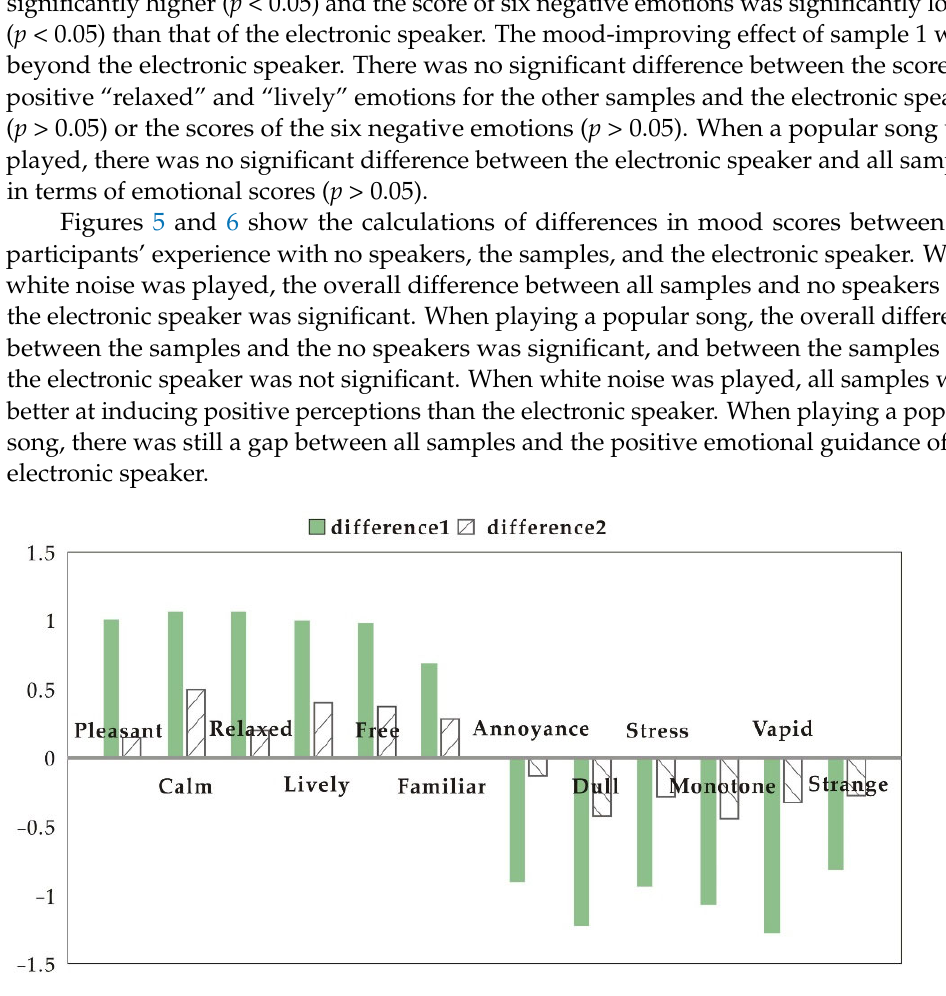
Table 11. Differences between 12 emotional perceptions under different sound conditions (popular song).